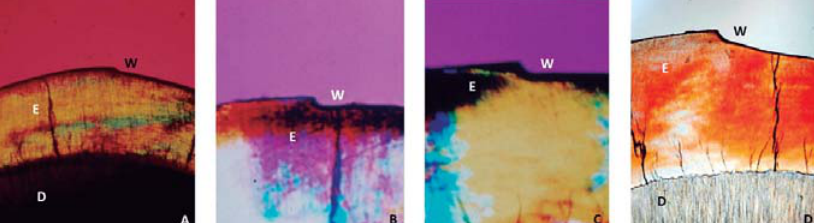
Figure 8- A: Ground tooth section presenting 25 μm enamel loss after 3 applications, of 15 seconds each, of a mixture of 18% hydrochloric acid and pumice (25X); B: 23 μm after 4 applications, of a mixture of Prema Compound enamel microabrasive; C: 42 μm after 4 applications , of 1 minute each, of a mixture of 37% phosphoric acid and pumice; D: 80 μm after, after 4 applications, of 1 minute each, of Opalustre enamel microabrasive. The depression in the enamel convexity (W) designates where the microabrasion was performed. Analyzed by polarized light microscope; E: enamel; D: dentin;